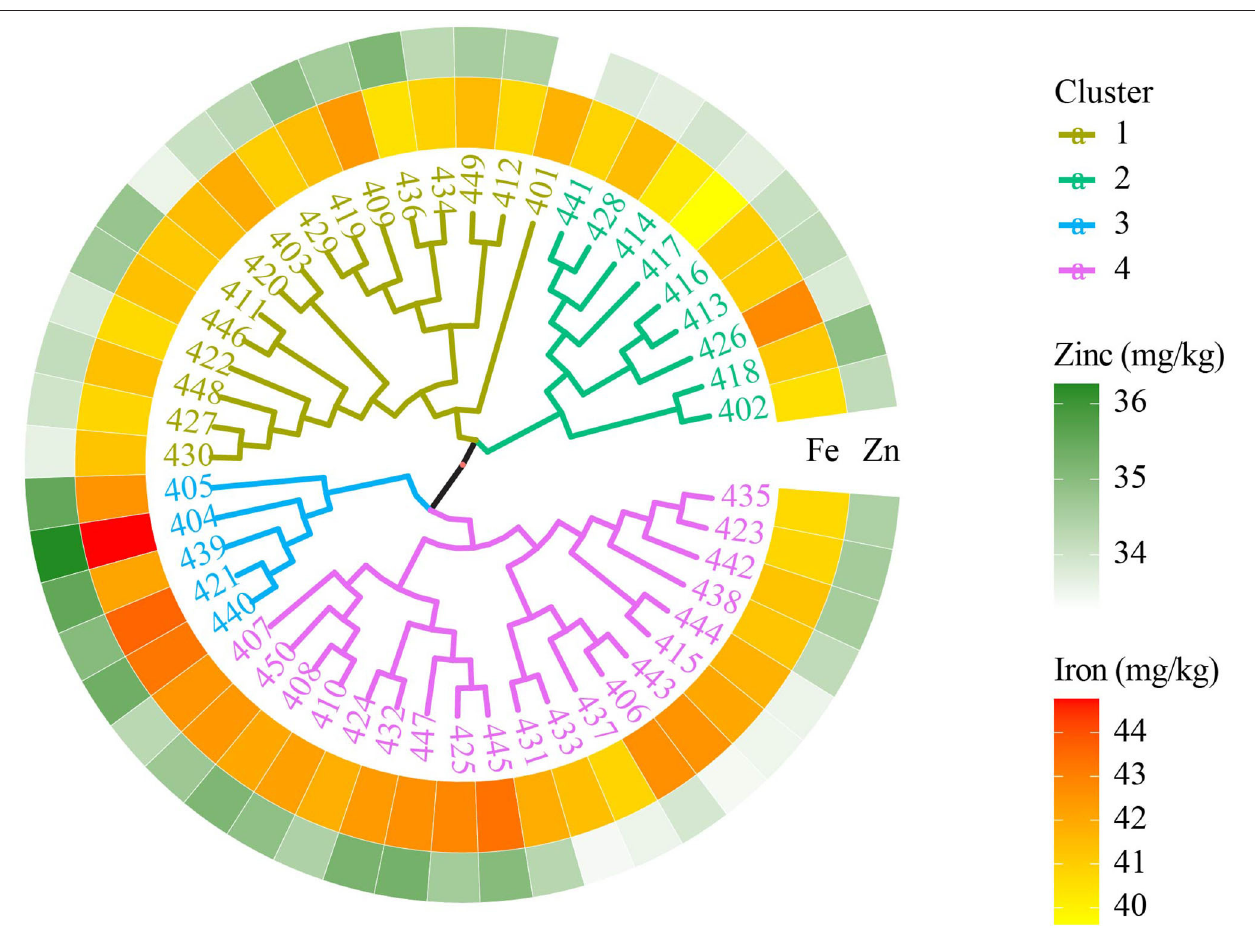
The highest grain iron (40.1 mg/kg) and zinc concentrations (42.08 mg/kg) were found at Khumaltar Among the tested genotypes, Zinc Shakti (entry 404) recorded the maximum grain zinc (33.5 mg/kg) and iron (36.6 mg/kg) concentration, while entry 440 recorded the maximum grain yield (4,775 kg/ha) but was at par in terms of grain zinc (28.9 mg/kg) and iron concentration (32.2 mg/kg). High heritability was